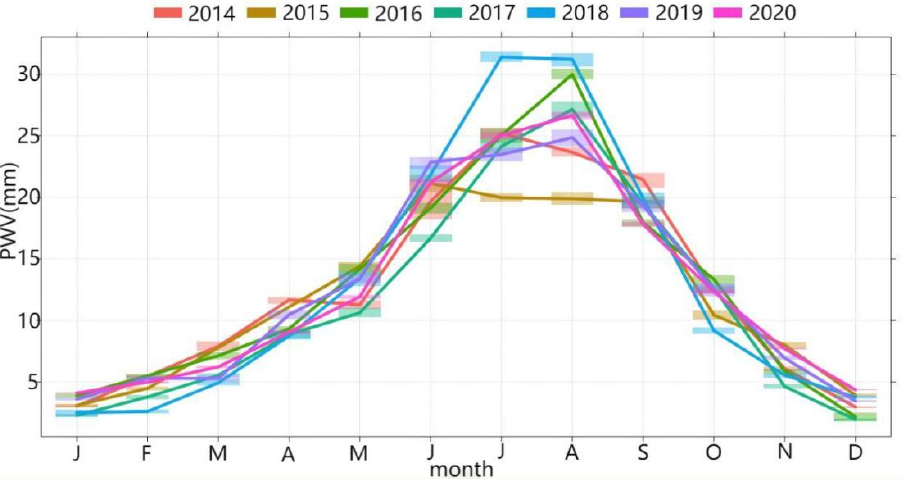
Figure 3. Monthly PWV line graphs of LPM area from 2014 to 2020.